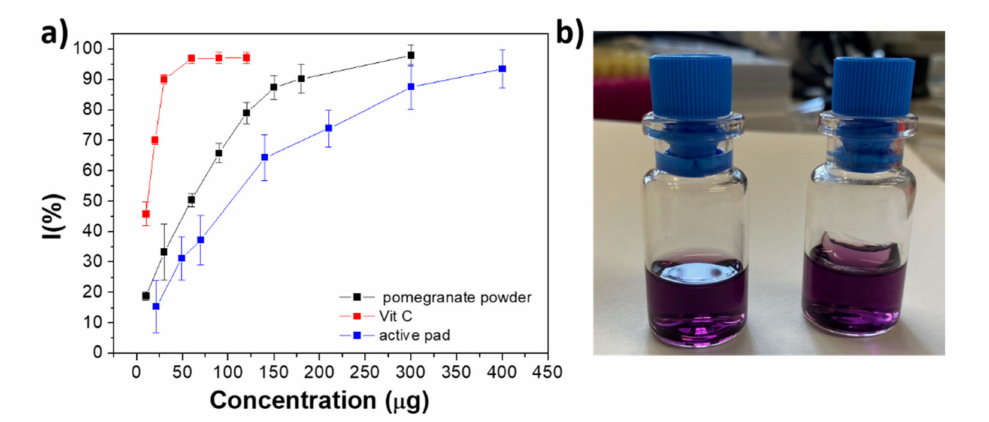
Figure 5. ( a ) DPPH radical scavenging activity of pomegranate powder (black line), SF-pomegranate powder pad (blue line) and vitamin C (red line) measured in the same experimental conditions. ( b ) Pictures of DPPH solution (left) and DPPH solution containing the active pad